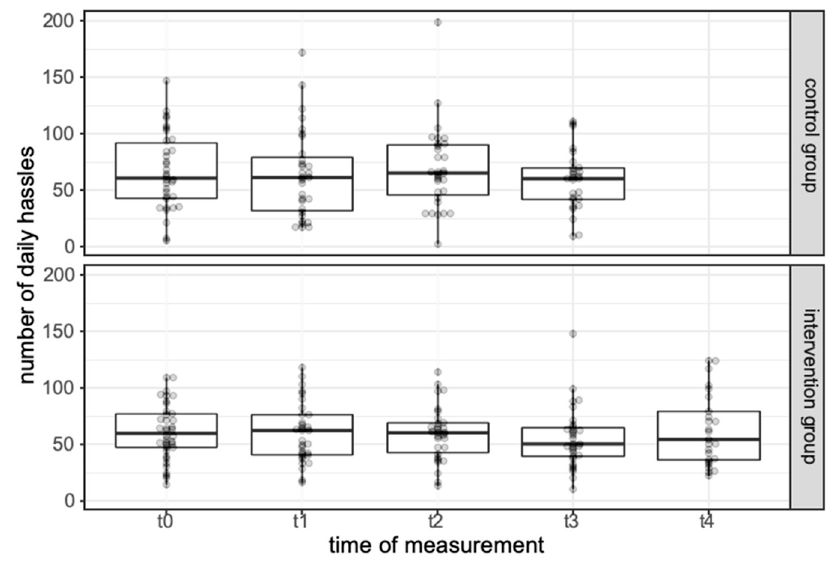
Figure A2. Trend lines for the mental health outcome separately for both groups.